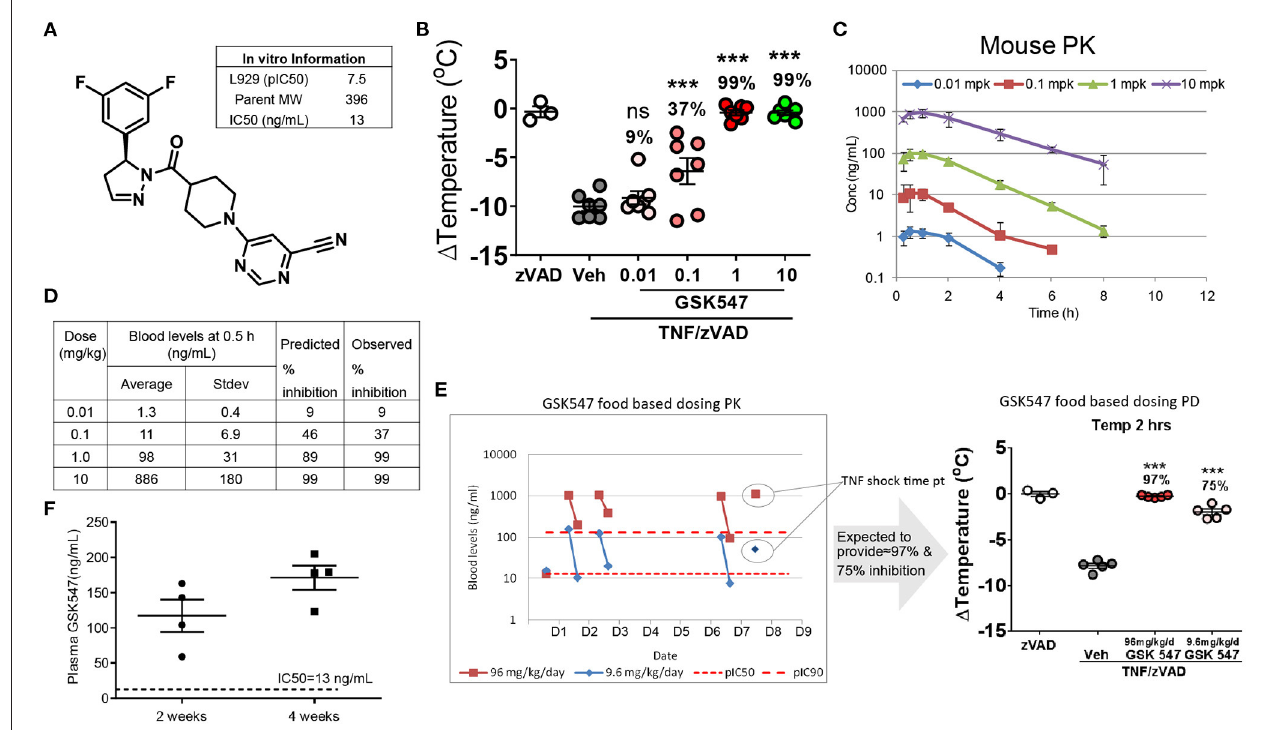
FIGURE 1 | Pharmacokinetics of GSK547 and its potent inhibition of RIPK1 in mice. (A) Chemical structure of GSK547 and its reported in vitro IC50 (19). (B) Pharmacodynamics dose-response in an acute TNF/zVAD shock model on body temperature at 0.01, 0.1, 1, and 10 mg/kg GSK547 administered orally. mpk = mg/kg. n = 3–7 mice per group. Mice were administered GSK547 orally at 0.01, 0.1, 1.0, and 10 mg/kg, then blood drug levels at serial time points were shown (C,D) . The average drug level from 0.5h post-dose was used to calculate the predicted RIPK1 inhibition, and actual body temperature change was calculated